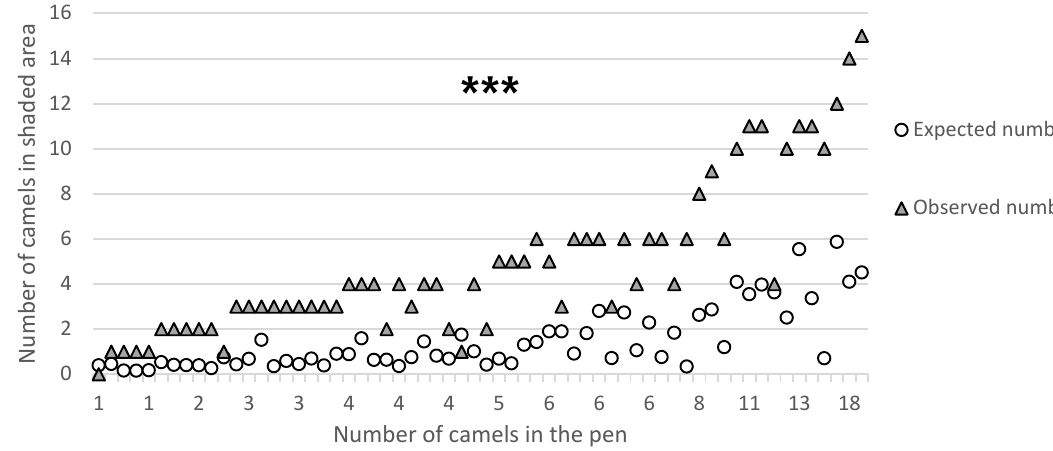
Figure 2. Comparison of the expected and observed number of dromedary camels in the shade in Group 1 pens (with different sizes and number of animals housed) at the camel market in Doha: comparison of the expected (white circles) and observed (grey triangles) numbers of dromedary camels located in shaded areas. *** means chi-square p < 0.001.